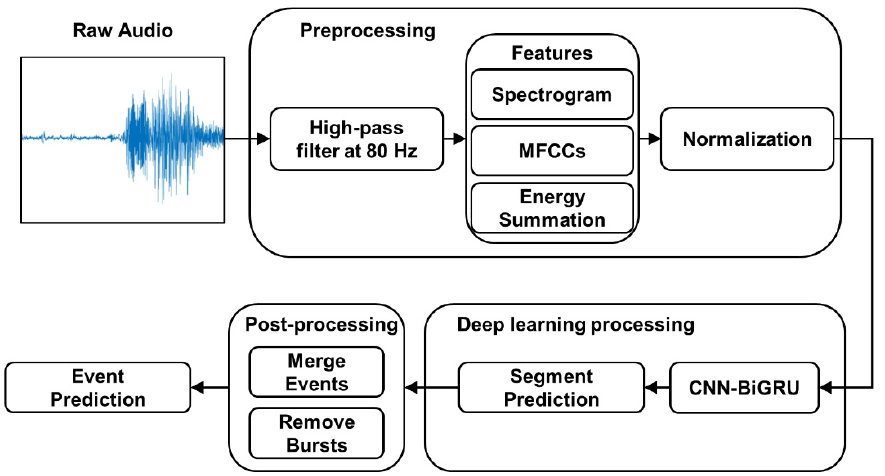
Figure 4. Pipeline for preprocessing, deep-learning processing, and postprocessing. Detailed